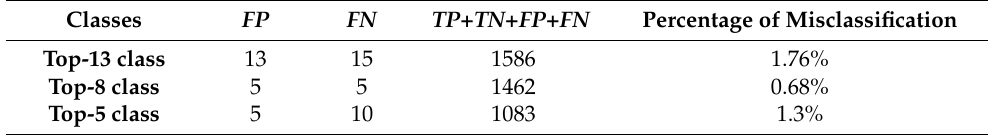
Table 8. Misclassification.